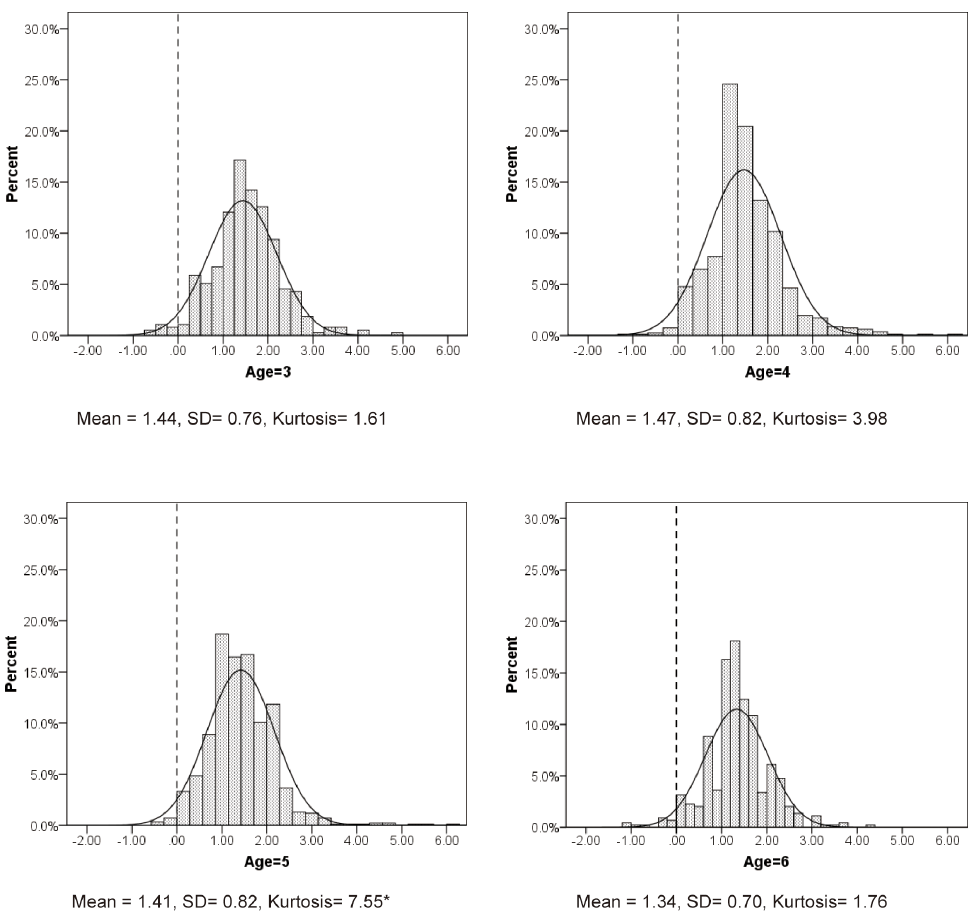
Figure 2. Distributions of spherical equivalent refractive error by age. The rectanglesrepresent the actual distributions of spherical equivalent refractive errors. The red lines represent normal distributions with the same means and standard deviations for each age. *In the group aged 5, the data of one outlier (female, 2 8,50 D in the right eyes) is not included.